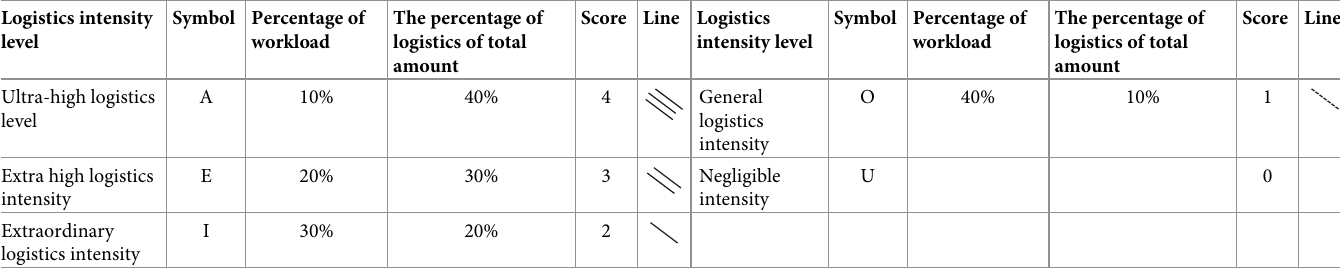
Table 5. Classification of logistics intensity